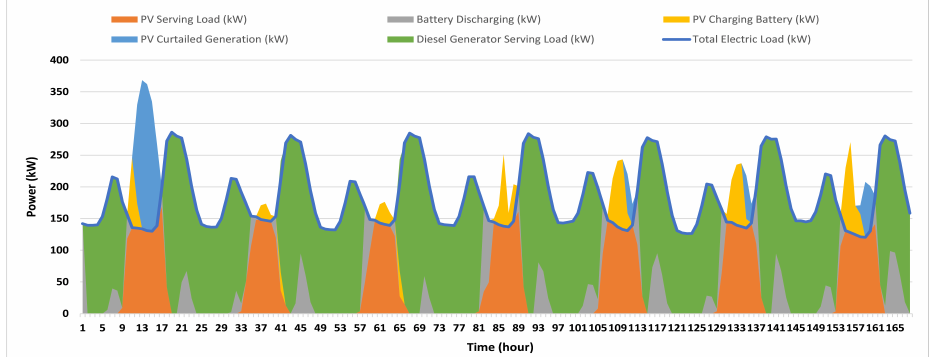
Figure 12. Microgrid operation during a week in the dry season: Case 2.